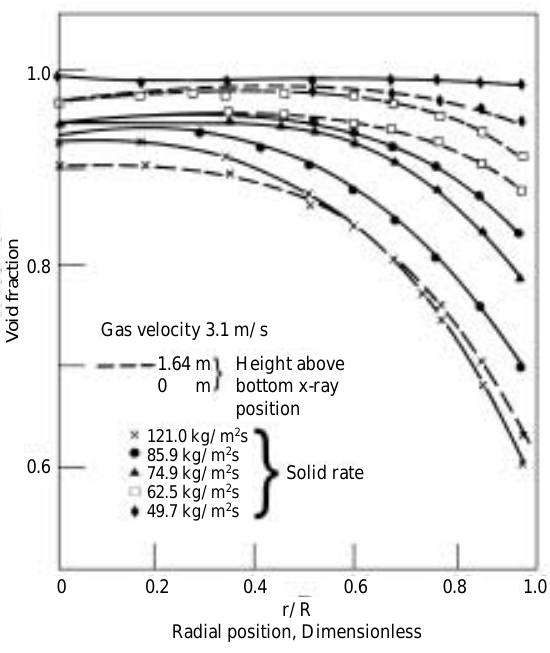
Fig. 11 Radial variation of void fraction, constant gas velocity [30]